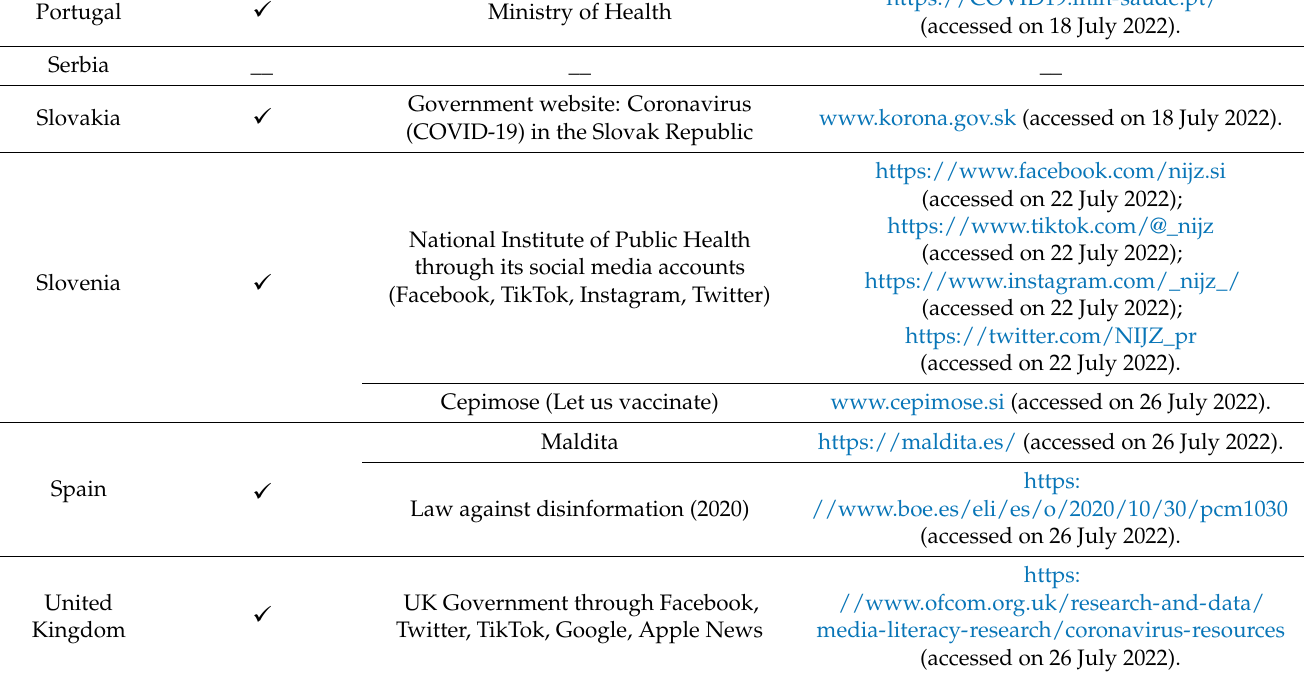
Table 4. Online platforms fighting COVID-19 related